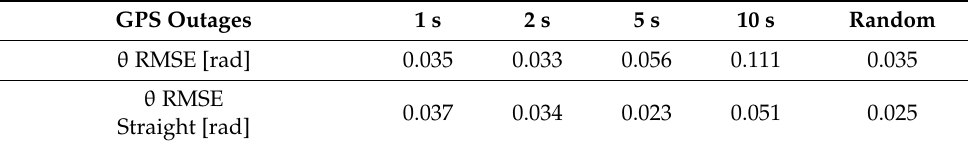
Table 7. RMSE of position EVMs for different GNSS